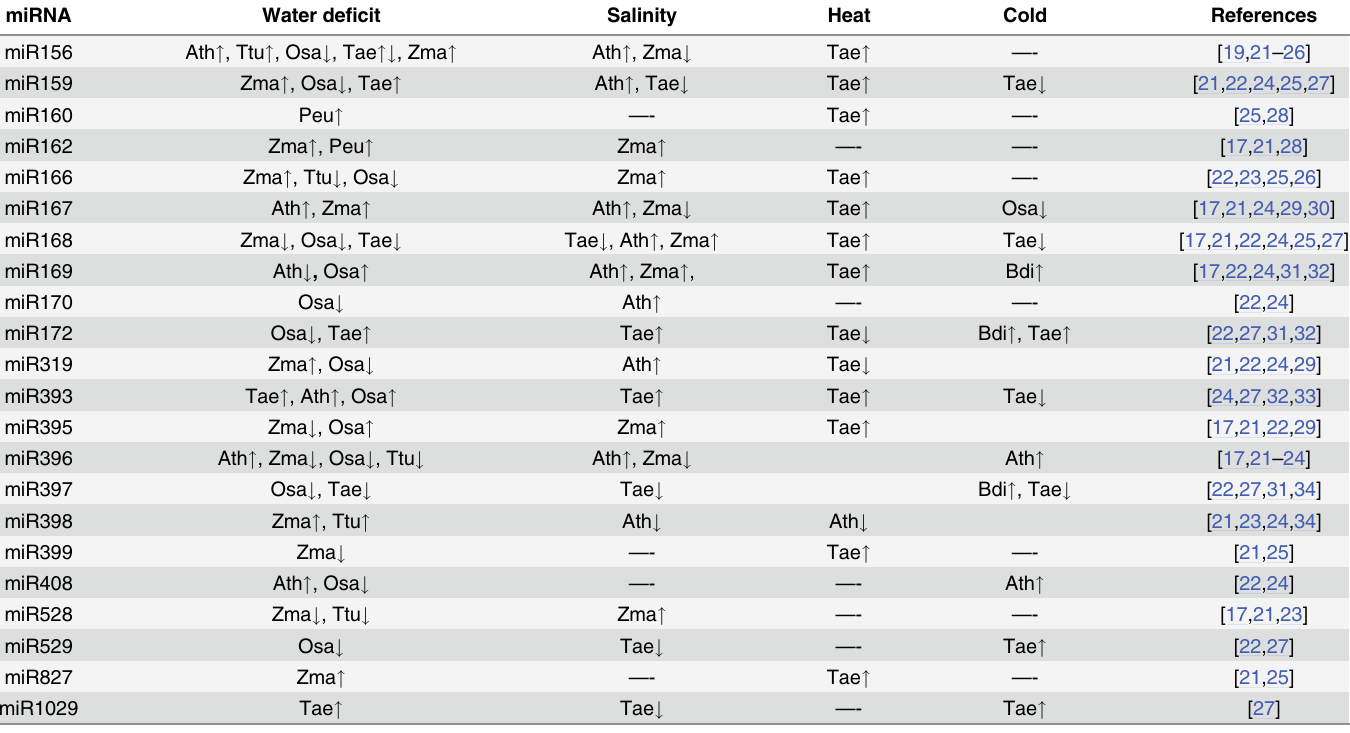
Table 1. Stress responsive microRNAs and their response to different abiotic treatments in various plant species. miRNA Water de fi cit Salinity Heat